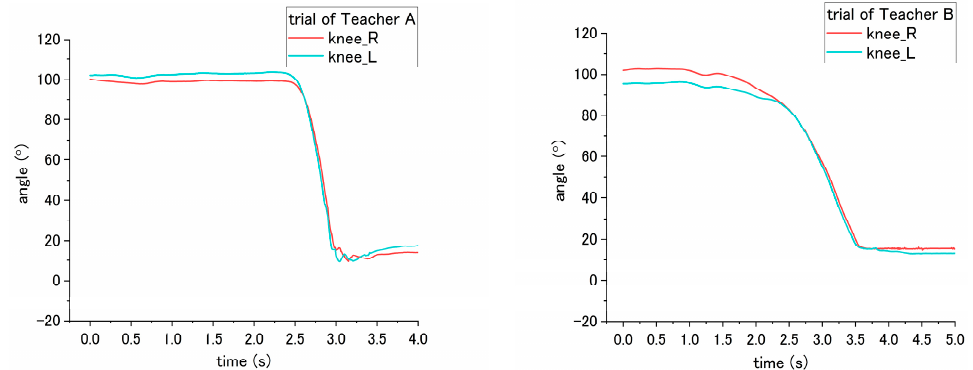
Figure 18. Flexion angle of patient’s knee during step No. 11 when the incorrect way was conducted during step No. 11.